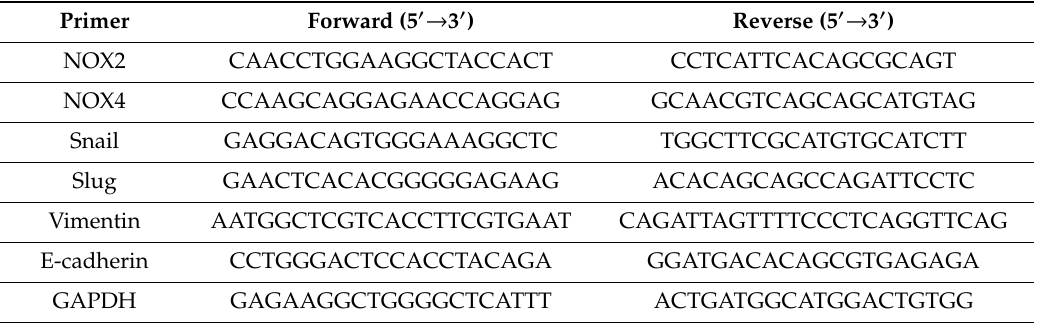
Table 1. Specific